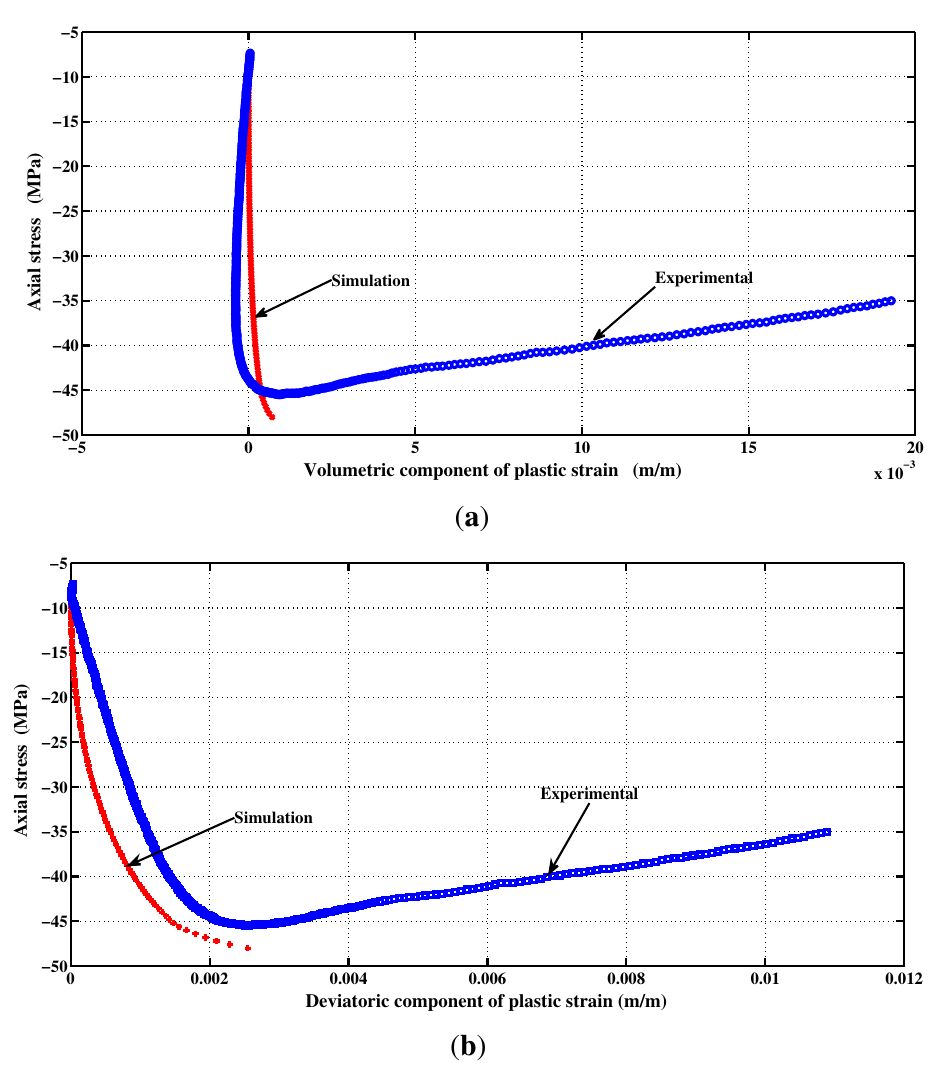
Figure 8. Volumetric and deviatoric plastic components correlations for data obtained by simulation and experiment. ( a ) Volumetric; ( b ) Deviatoric.